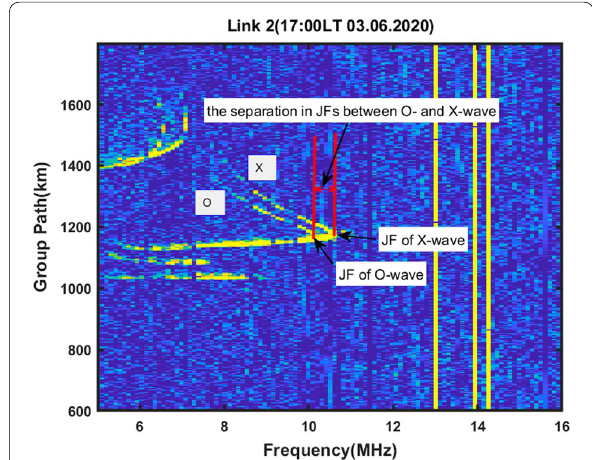
Fig. 1 An oblique ionogram indicating JF, O- and X-wave traces, the separation in JFs between O- and